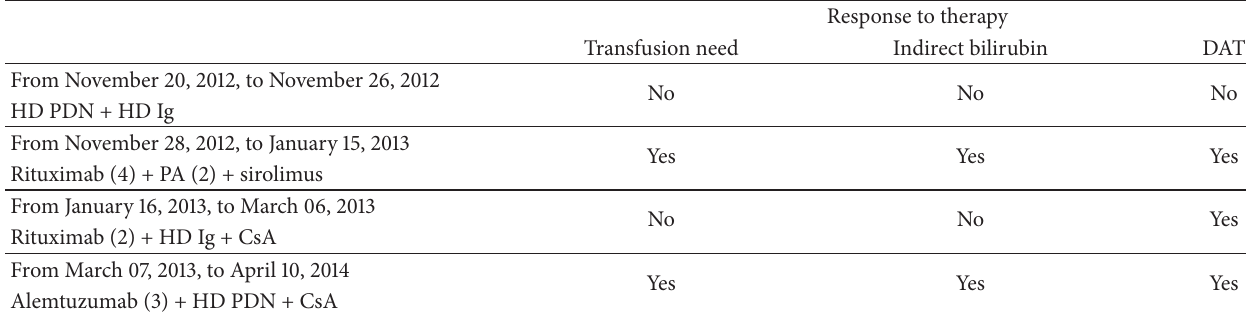
Table 1: Immunosuppressive therapies and response.